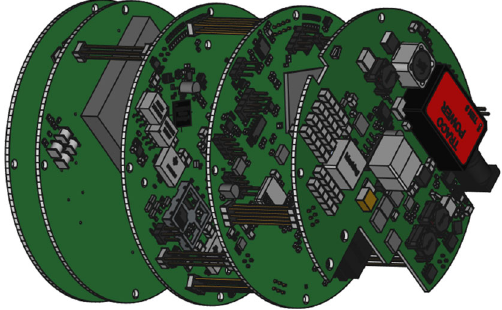
Fig. 8 iPMT electronics stack. The PMT is mounted on the left side. From left to right, Base, HVboard, Readout Board, SCCU and POE. Spacing between the boards is not to